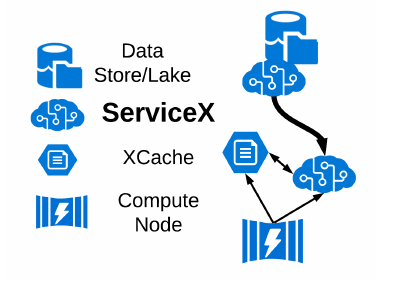
Figure 2: ServiceX, a data delivery service from the IRIS-HEP DOMA